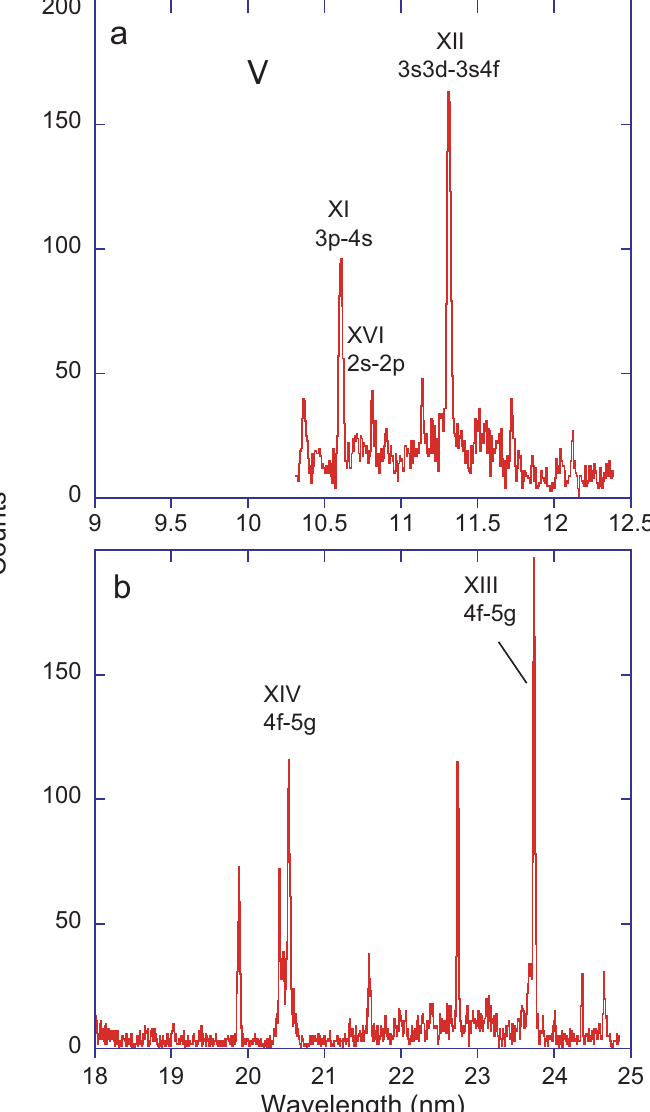
Figure 9. Beam-foil spectra of V at an ion beam energy of 30MeV. Observation at the foil. Line width (FWHM) 0.03nm. The strongest lines are identified by the spectrum number. ( a ) Spectrum 10.5 to 12.5nm; ( b ) spectrum 18 to